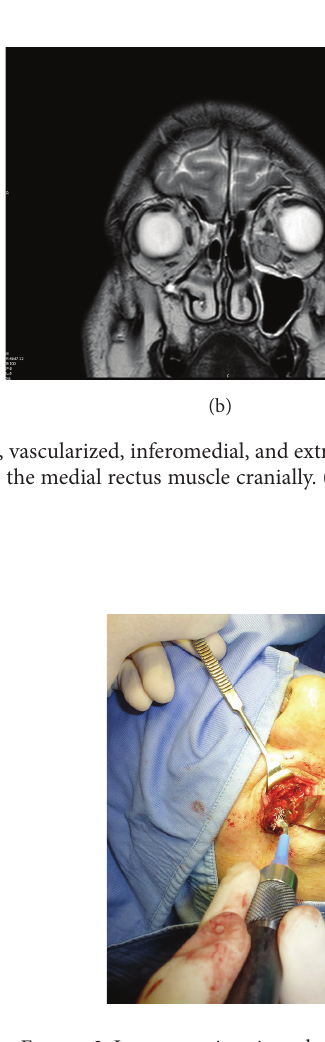
Figure 2: Intraoperative view: through transconjunctival approach and lateral canthotomy (swinging eyelid incision), we performed a subperiosteal orbital floor dissection. Then, the periorbita was incised inferiorly and medially. The well-encapsulated lesion was removed using a cryoprobe, pulling it laterally.